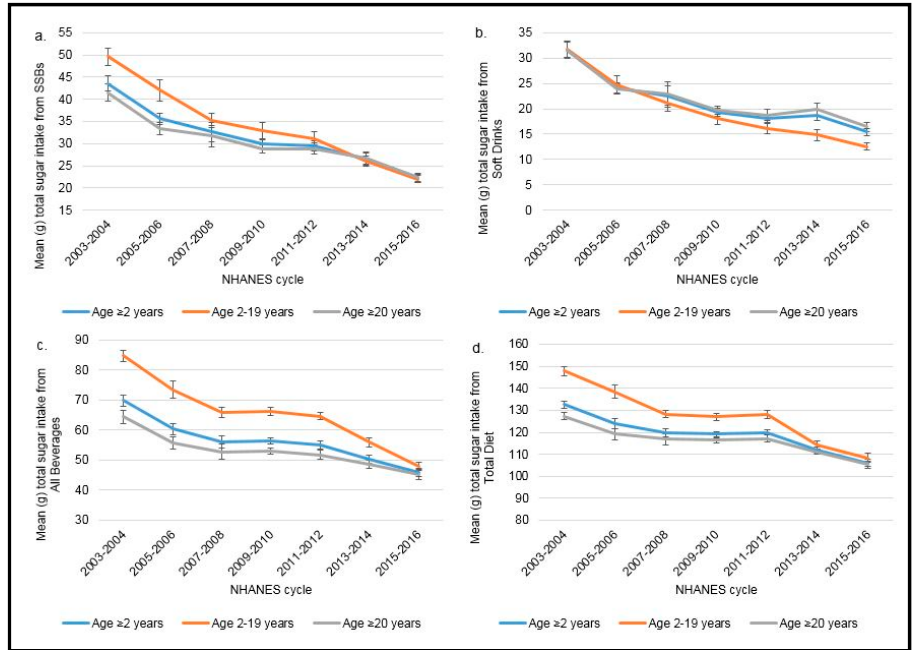
Figure 2. Trends in total sugar intake (g) from ( a ) SSBs; ( b ) soft drinks; ( c ) all beverages; and ( d ) the total diet in the US by age group.